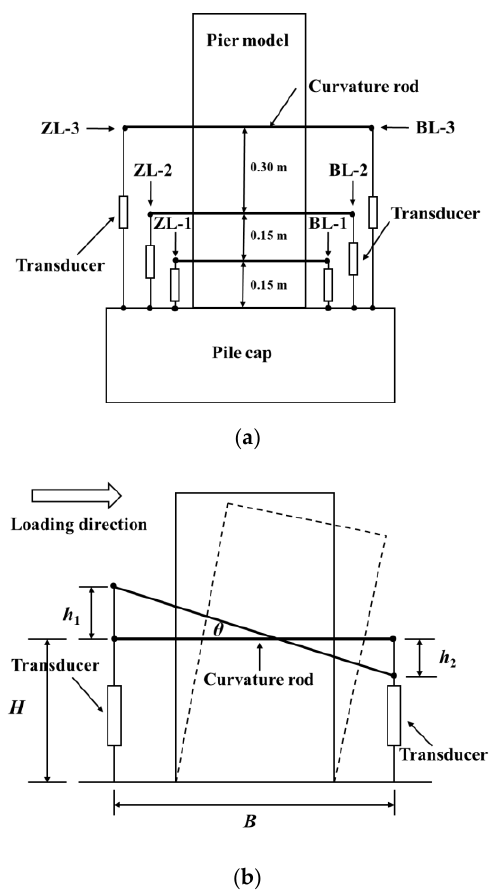
Figure 5. ( a ) Setup of curvature measurement rod and cable-extension transducer at the plastic hinge; ( b ) Schematic diagram of curvature calculation.